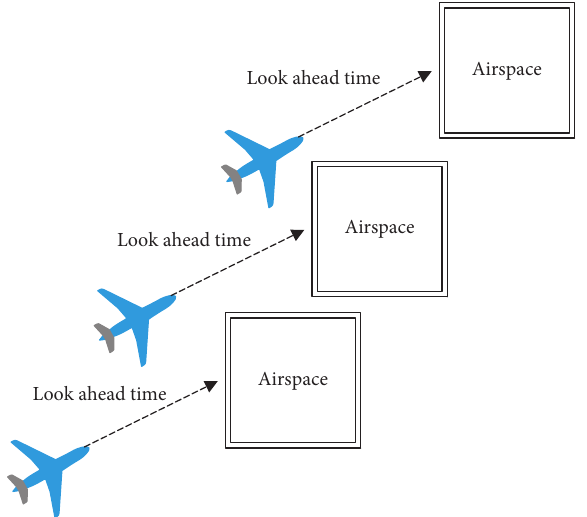
Figure 8: Schematic diagram of detailed airspace intrusion warning processing.